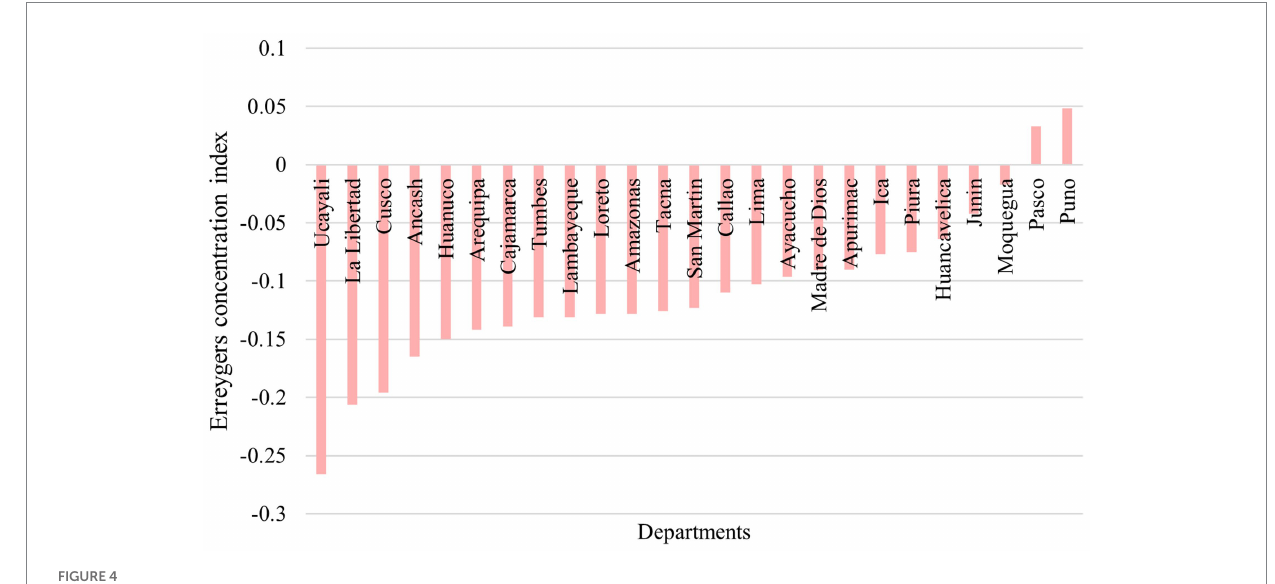
FIGURE 4 ECI for anemia among Peruvian children by